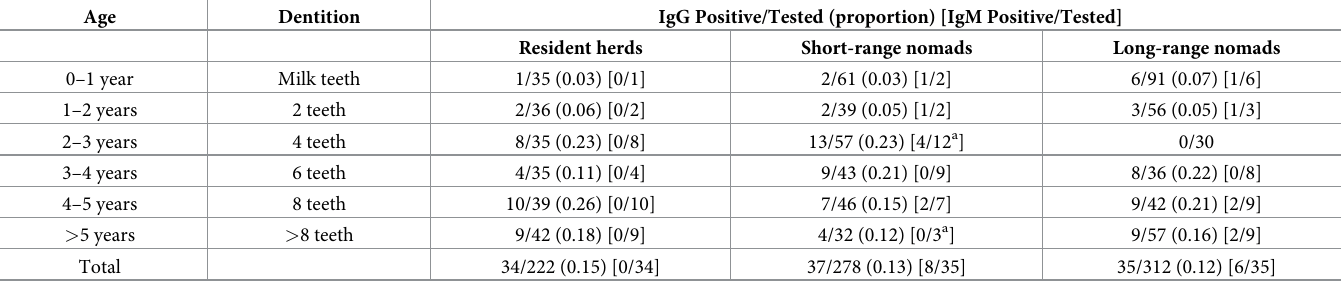
Table 4. Results of an age-structured serosurvey conducted in small ruminants from 6 resident herds and 22 nomadic herds of Younoufere area, Ferlo, Senegal, August 2015-May 2016.